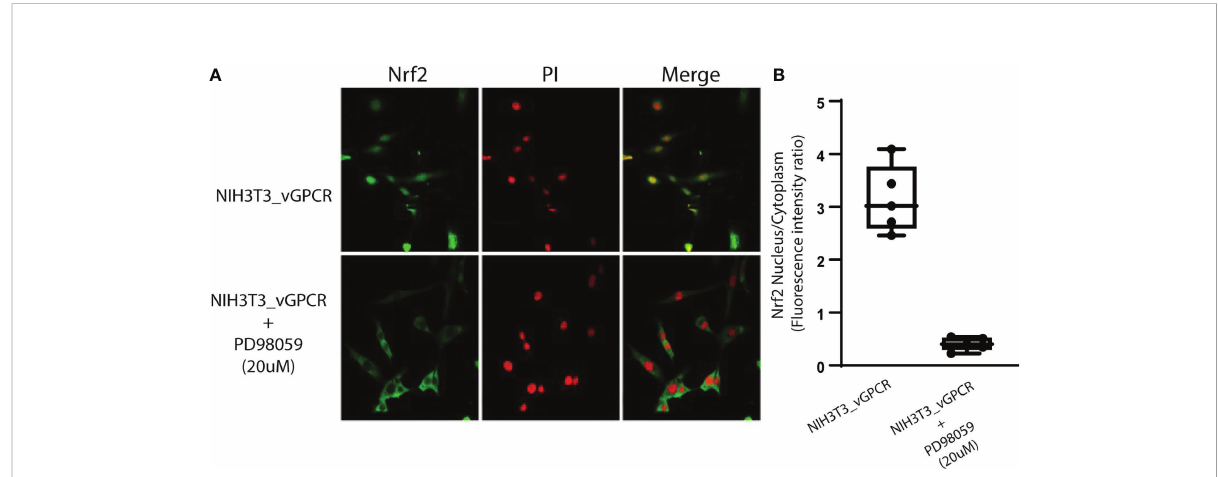
FIGURE 6 Inhibition of ERK1/2 activity block Nrf2 nuclear translocation. (A) Confocal microscopy of NIH3T3 stable cell lines for vGPCR control or treated with PD98059 20uM and incubated with anti-Nrf2 and anti-rabbit FITC. For visualizing the nucleus, propidium iodide was used. Magni fi cation 40X. (B) Quanti fi cation of fl uorescence intensity for the nucleus/cytoplasm localization of Nrf2 in the different conditions from (A)